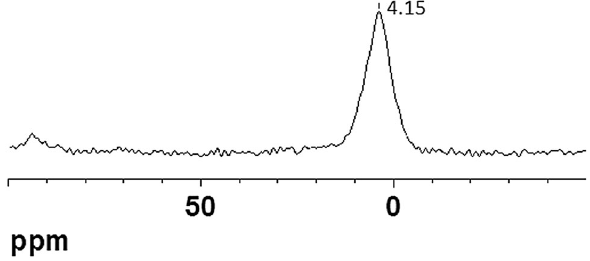
Fig. 15 The 27 Al MAS NMR spectrum of the unaltered sample K1 (11 kHz, RT). The peak at 4.15 ppm corresponds to the THDA complex